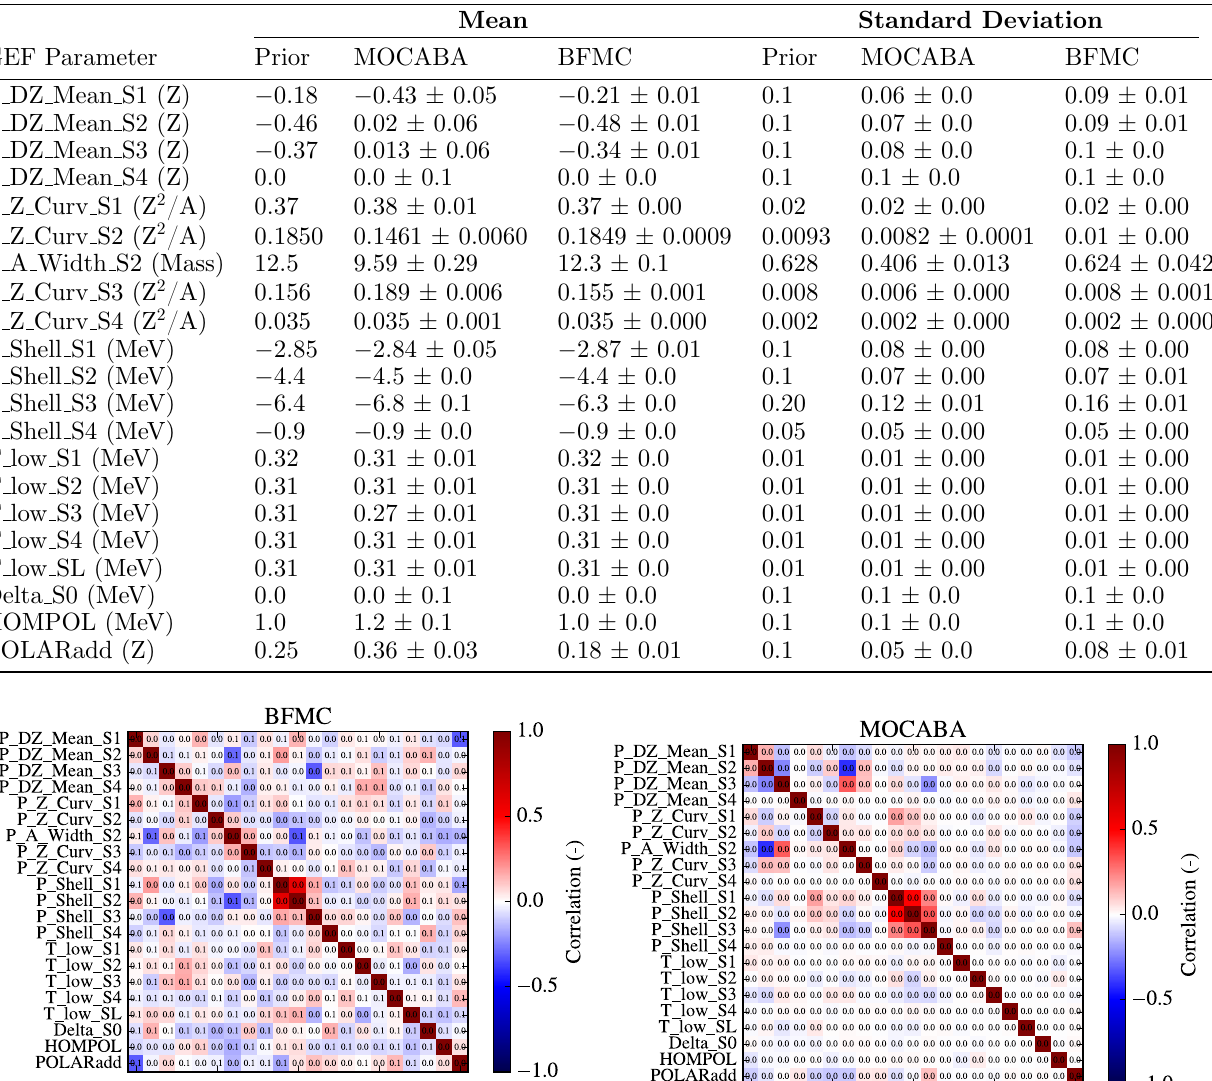
Table 5. Prior and posterior means and standard deviations of GEF’s model parameters without using MLO. 95% confidence intervals are shown that were estimated with bootstrap sampling.